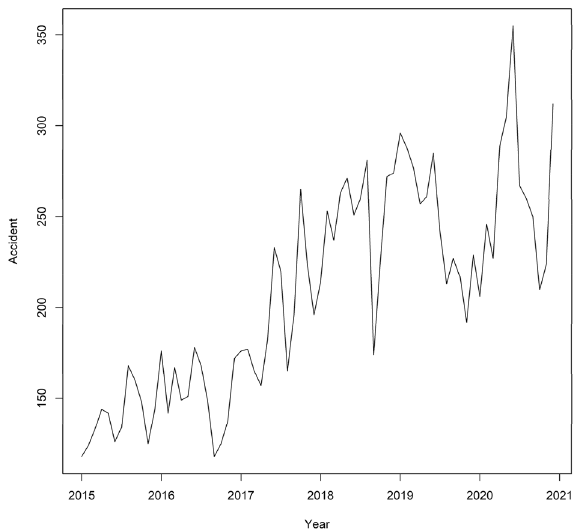
Figure 1. Time series plot of the number of accidents in Kerman province,